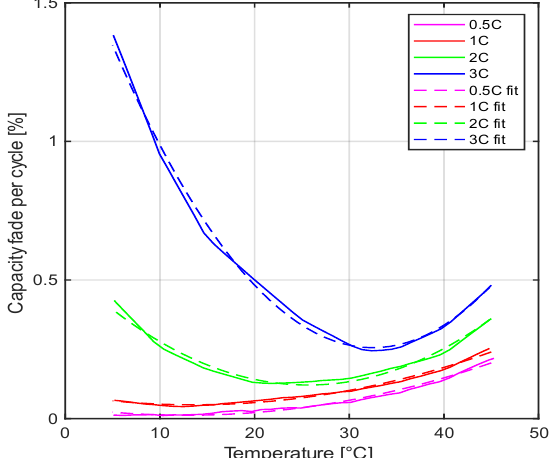
Figure 2. Influence of discharge rate and temperature on degradation.